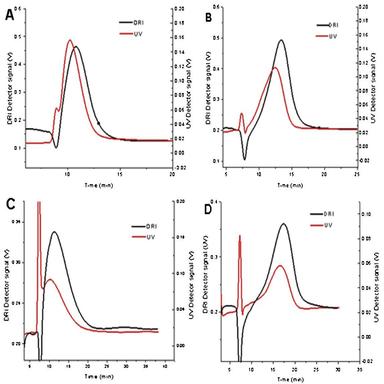
Superimposed fractograms for (A) SMA 1,(B) SMA 2,(C) SMA 3 and (D) SMA 4. Detectors: DRI(blue) and UV at 254 nm (red)fractograms. Experimental ThFFF conditions as in 2 (For interpretation of the references to colour in this figure legend, the reader is referred to the web version of this article).